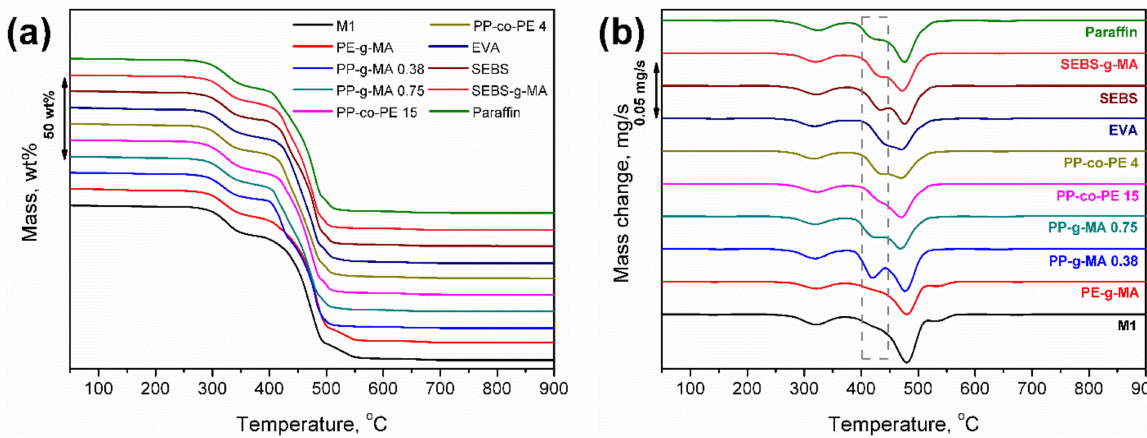
Figure 14. Plots of ( a ) mass change and ( b ) differential thermogravimetric curves of compatibilized M1